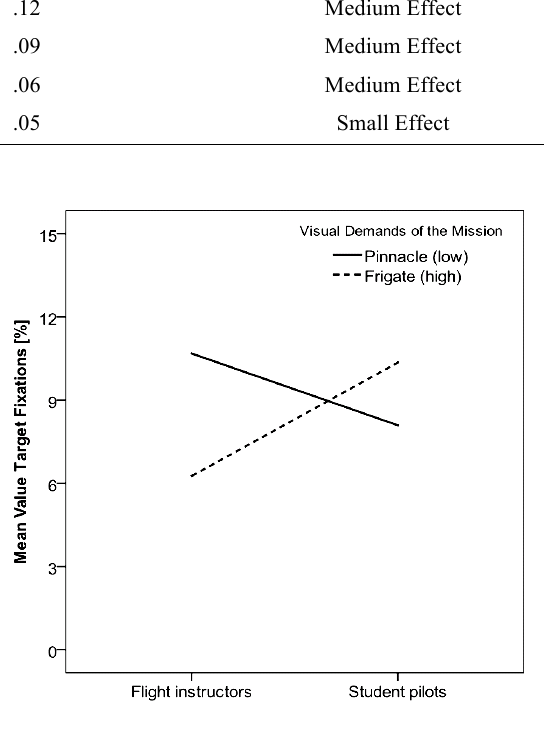
Figure 9. Interaction Effect. Frigate. A different type of expert scanning